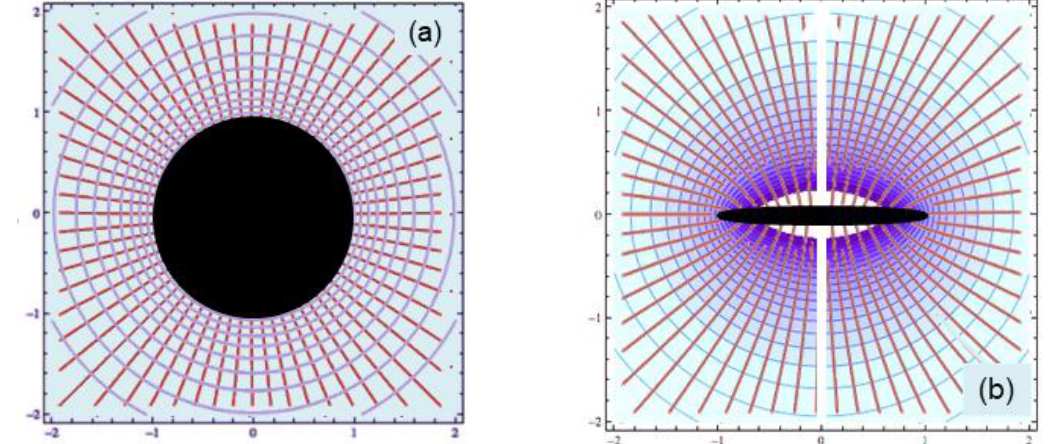
Figure 9. Lines of force (red) superimposed on ellipsoidal contours of constant potential (purple or blue): ( a ) Sphere (black circle) with c / a = 1, where the lines of force are perfectly radial and the orthogonal equipotential surfaces are spherical; ( b ) Oblate body (black ellipse) with c / a = 0.1, as in spiral galaxies, where the lines of force are not radial and are only perpendicular to the body for the special axial directions. White arrow = spin axis. Equipotential contours are ellipses which become rounder with distance. Contours near the oblate are too finely spaced to be shown.